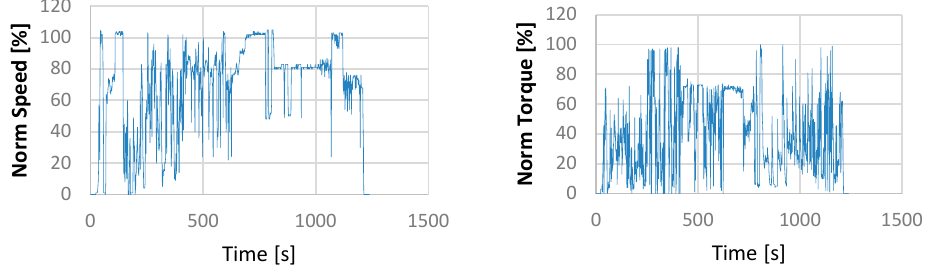
Figure 1. NRTC: Normalized Speed; Normalized Torque.